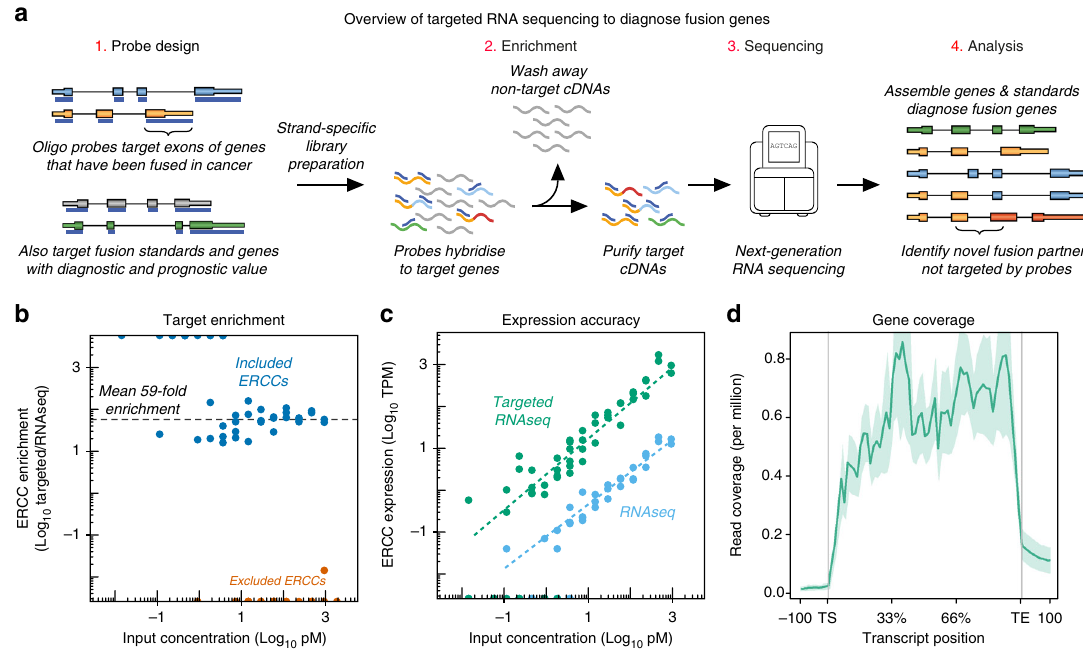
Fig. 1 Overview of targeted RNAseq and panel validation. a Schematic of targeted RNAseq process. b Scatterplot of targeted RNAseq enrichment for ERCCs included on (blue) or excluded from (orange) the blood panel. c Abundance of captured ERCCs before and after targeted sequencing on blood panel. d Metagene plot of K562 targeted RNAseq read coverage across all genes on the blood panel. TS = Transcript Start site; TE = Transcript End